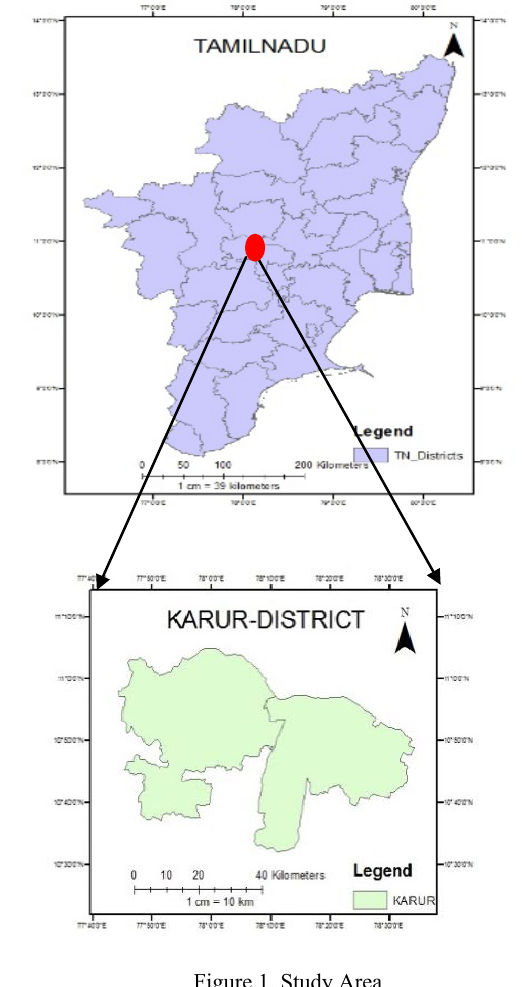
Figure 2. Rice growing blocks (1, 2, 3, 4)